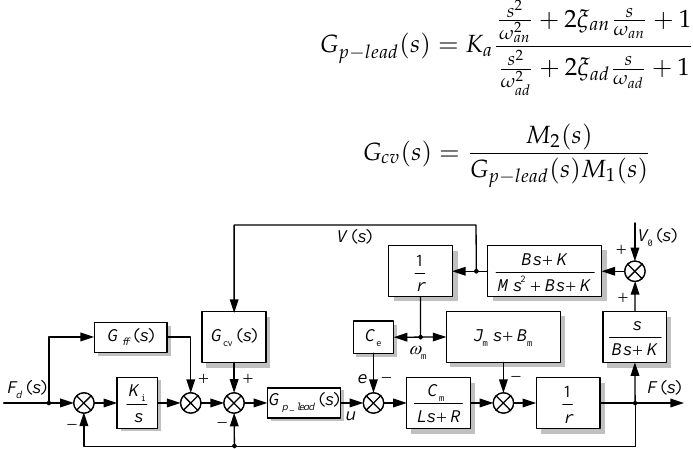
Figure 6. Tension controller of the cable